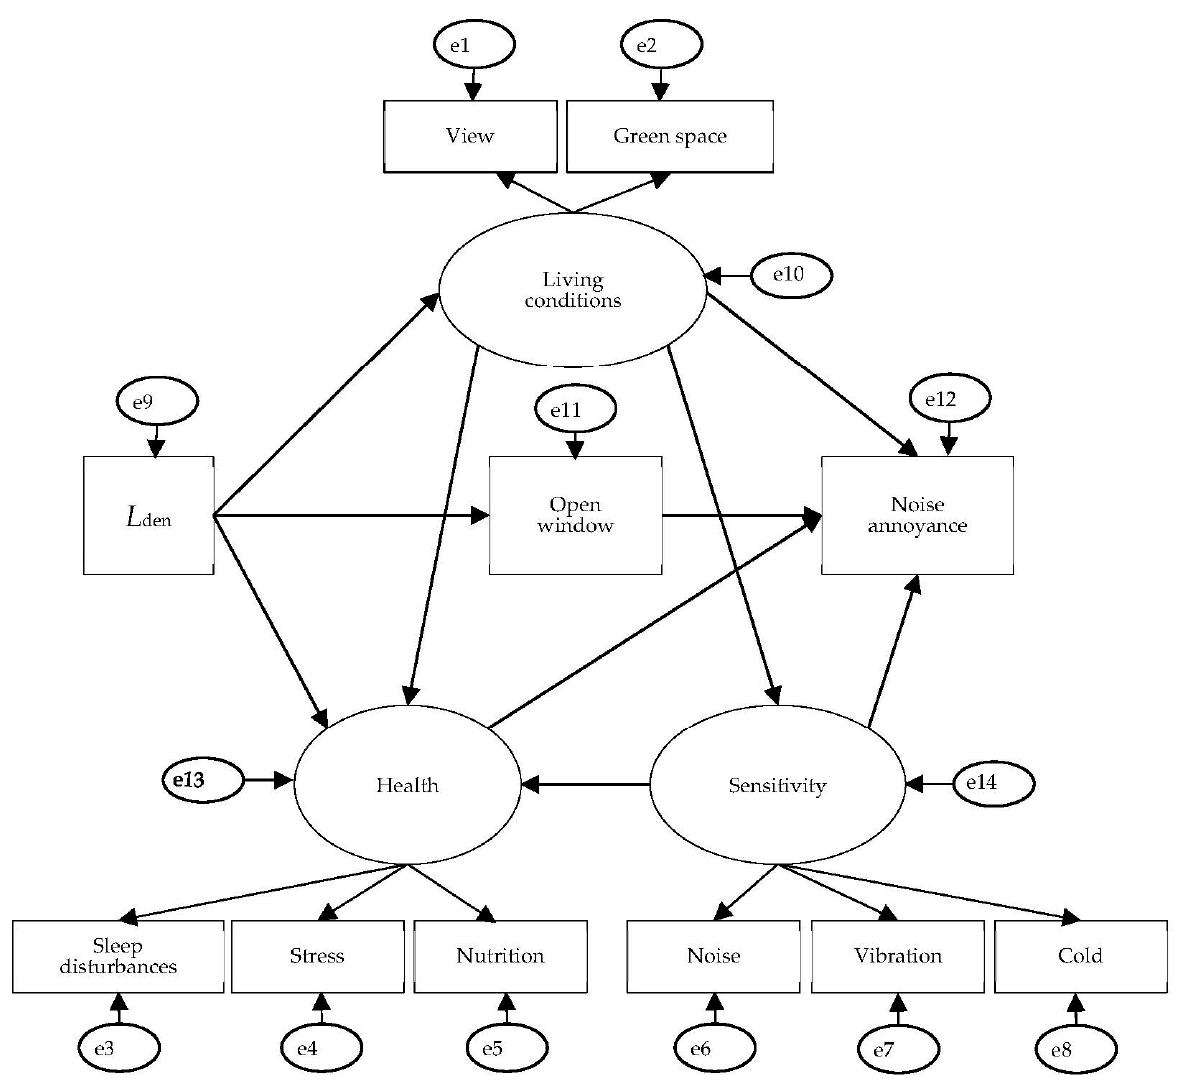
Figure 2. The final version of the structural equation model estimated for noise annoyance in the 2019 and 2020 surveys.